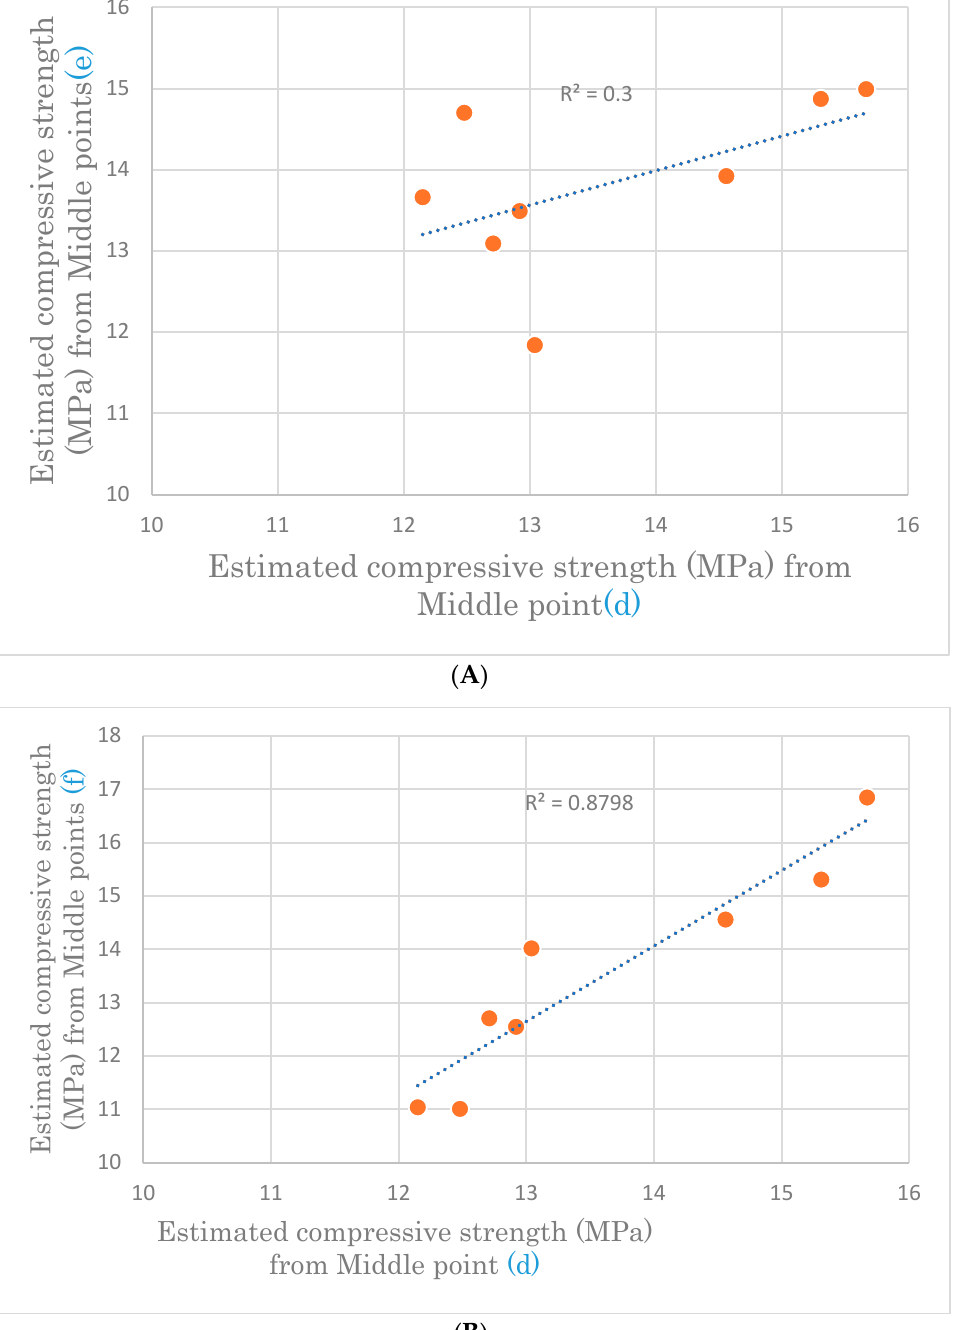
Figure 10. Relationship between estimated compressive strength from middle points. ( A ) The correlation of compressive strength at middle points (d) and (e); ( B ) The correlation of compressive strength at middle points (d) and (f).